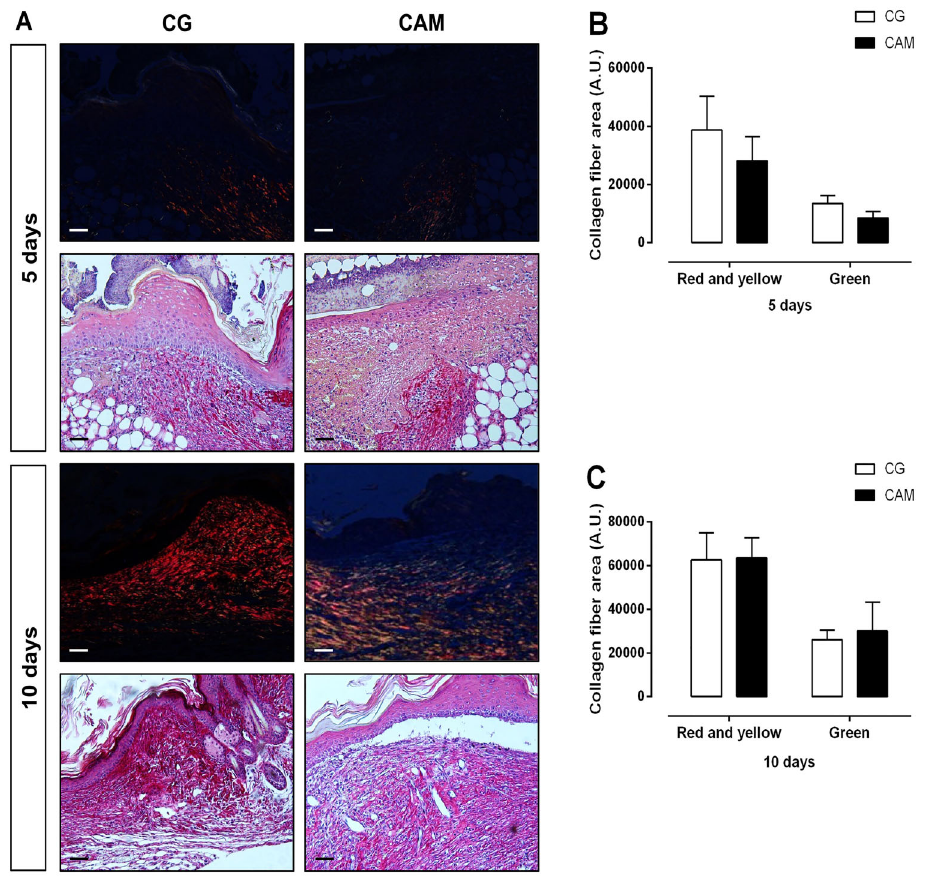
Figure 4. A , Picrosirius red-stained sections of wounds under polarized light followed by sections without polarization of control (CG) and chitosan and alginate membrane (CAM) groups, 5 and 10 days post-wounding. B and C , Analysis of collagen fi bers (red and yellow and green) area of CG and CAM groups on days 5 and 10 post-wounding. The images were acquired under a fi nal magni fi cation of 10 (cid:3) (scale bars: 100 m m). The data are reported as means ± SE of 5 animals per group (Student ’ s t